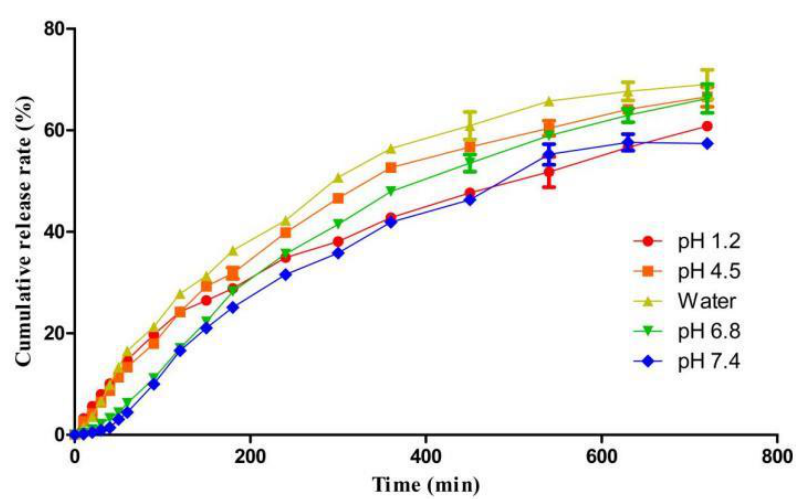
Figure 5. Effect of various pH dissolution media on naringin release behavior.